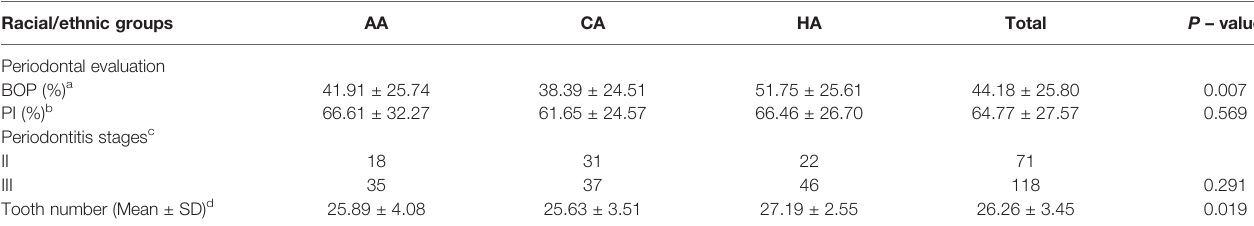
TABLE 2 | Periodontal characteristics of the study cohort. Racial/ethnic